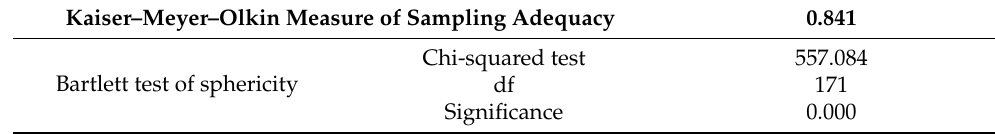
Table 2. KMO and Bartlett’s test of FA approach.